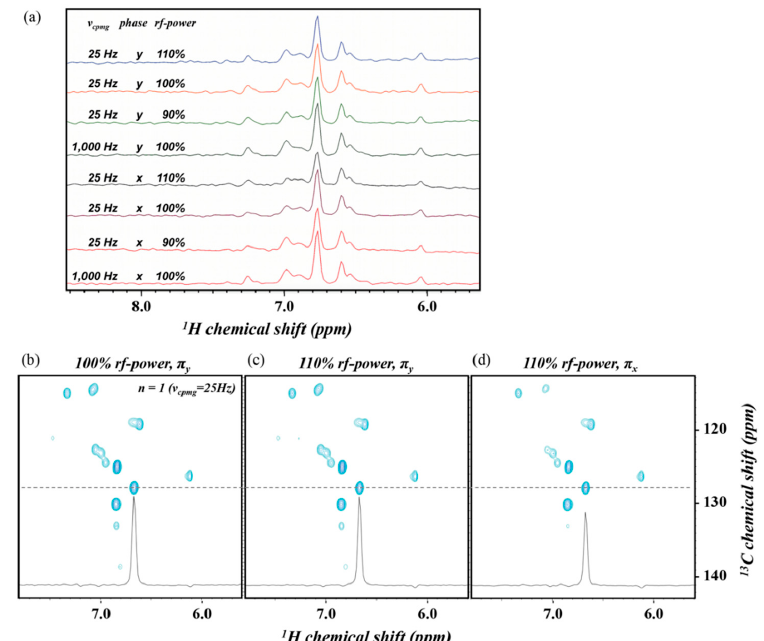
Figure 3. ( a ) Comparison of the peak intensities in 1D spectra of aromatic 13 C rc CPMG experiments, obtained by setting the indirect 13 C chemical shift evolution period t 1 to zero at 298 K with a 1 H static magnetic field of 500 MHz. The ν cpmg value (25 or 1000 Hz) is indicated to the left of each 1D spectrum, together with the phase of the 13 C π pulse applied in the U-element ( x or y ), and the relative rf field strength of the 13 C CPMG refocusing π pulses normalized against a calibrated pulse (90%, 100%, or 110%). The CPMG frequencies of 25 and 1000 Hz correspond to each of the 20 ms CPMG periods containing one and 40 spin-echo cycles, respectively. The rf field strength was changed by ±10% (±0.92 dB) with respect to the calibrated power (10 kHz). The 13 C π /2 and π pulse lengths were maintained at 25 and 50 μ s, respectively; ( b – d ) Two-dimensional aromatic 1 H/ 13 C TROSY planes measured with the lowest ν cpmg value (25 Hz, n = 1). The 13 C π pulse in the middle of the U-element was applied with a phase of y ( b ), y ( c ), and x ( d ). The rf field strength of the π pulses in the CPMG and U-element periods was set at the exact ( b ) and 10% higher ( c , d ) power. One-dimensional cross-sections along the 1 H dimension at the 13 C frequency indicated by the dashed lines are shown in the 2D spectra. The experiments were performed using a Bruker spectrometer.